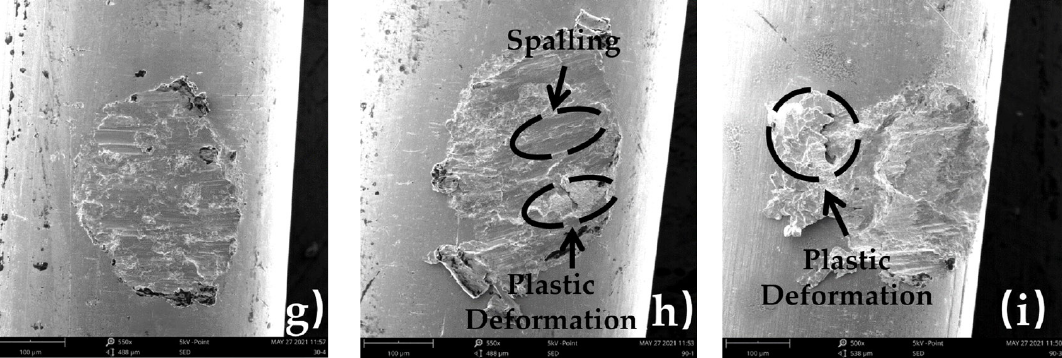
Figure 7. SEM images of worn surface under different crossing angles and temperatures: ( a ) 20 °C— 30° ; ( b ) 200 °C— 30° ; ( c ) 400 °C— 30° ; ( d ) 20 °C— 60° ; ( e ) 200 °C— 60° ; ( f ) 400 °C— 60° ; ( g ) 20 °C— 90° ; ( h ) 200 °C— 90° ;( i ) 400 °C— 90° .